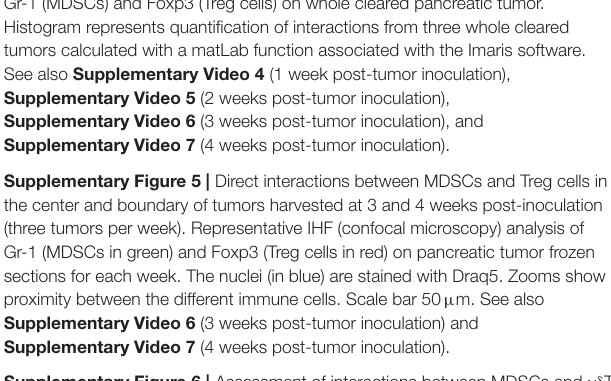
Supplementary Figure 4 | Dynamic interactions between MDSCs and Treg cells in orthotopic mouse model of pancreatic cancer. Panc02 cells were injected in the pancreas of C57BL/6 mice and tumors were harvested 1, 2, 3, and 4 weeks post-inoculation (three tumors per week). (A) Representative IHF (confocal microscopy) analysis of Gr-1 (MDSCs in green) and Foxp3 (Treg cells in red) on pancreatic tumor frozen sections for each week. The nuclei (in blue) are stained